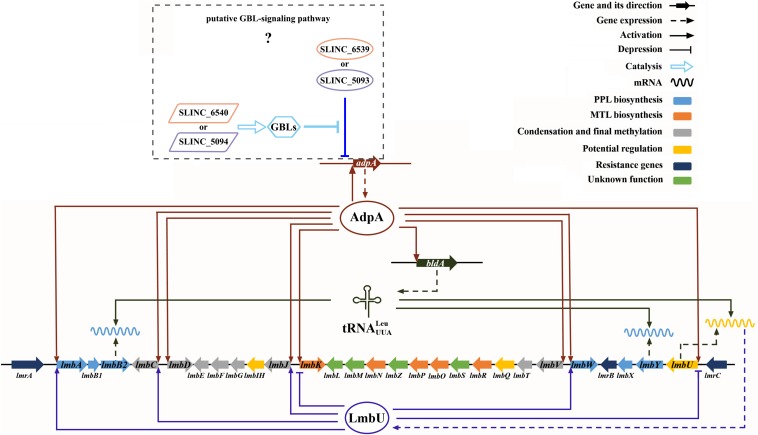
Cascade regulation of AdpAlin, LmbU, and BldA on lincomycin biosynthesis in S. lincolnensis.